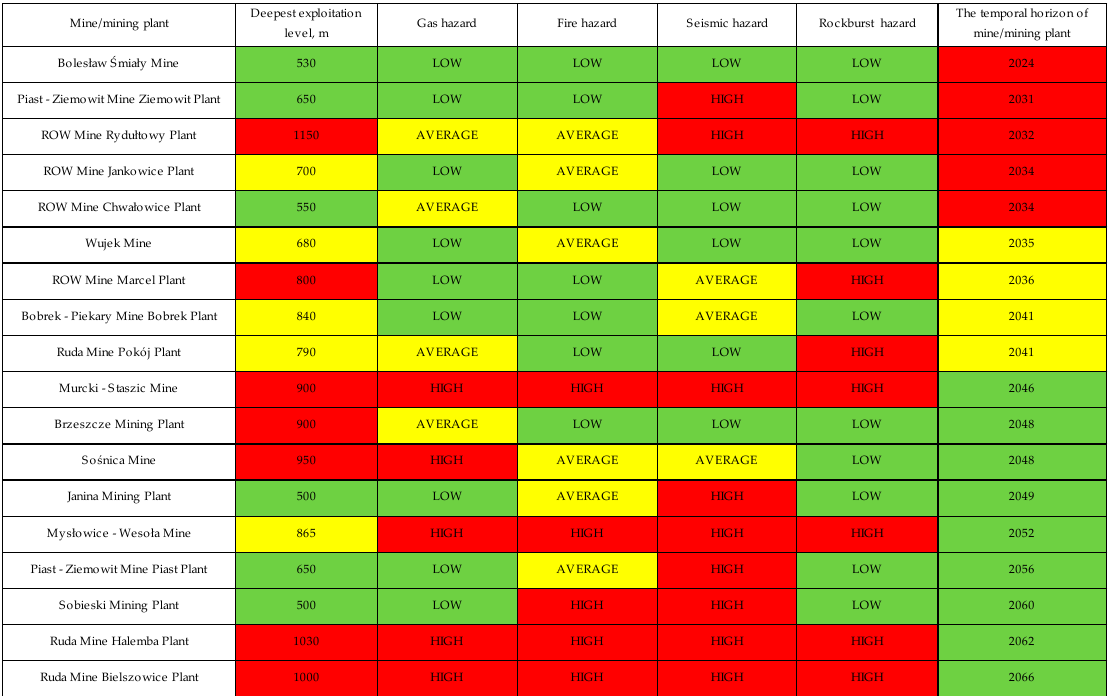
Figure 3. Summary of the results of analyses concerning the temporal horizon of mines and level challenges that hamper exploitation, from the authors’ study.